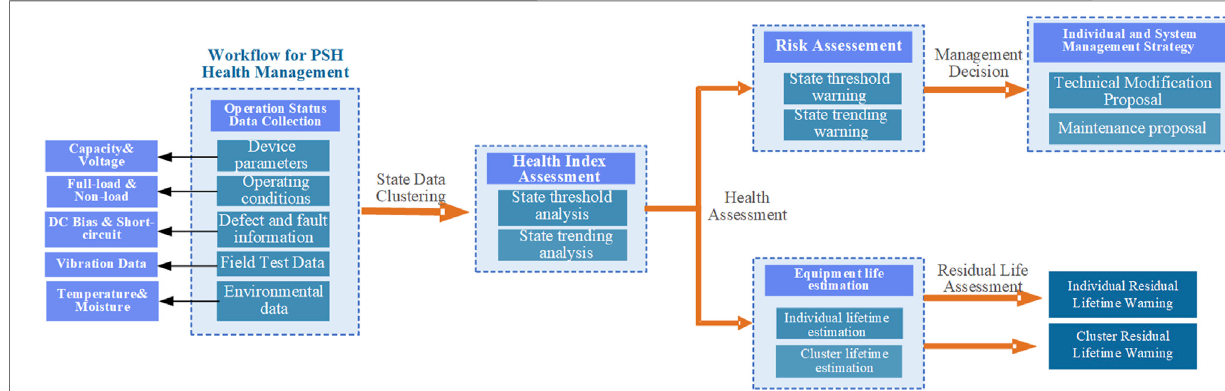
FIGURE 1 | PSH operational risk assessment technology diagram.